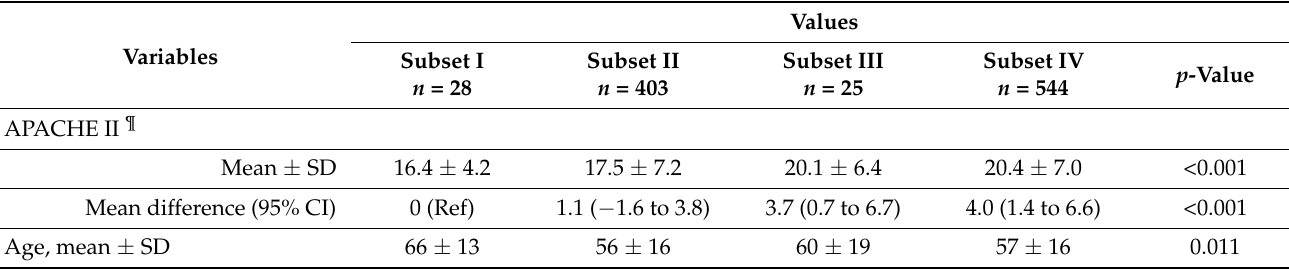
Figure 1. Distribution of 1000 patients (testing cohort) with moderate to severe acute respiratory distress syndrome (ARDS), based on cutoff values for the PaO 2 /FiO 2 ratio (150 mm Hg) and the positive end-expiratory pressure level (10 cm H 2 O) for each individual patient: ( A ) at the time of moderate/severe ARDS diagnosis (baseline); ( B ) after 24 h of standard critical care with protective mechanical ventilation. The dotted lines are placed at a PaO 2 /FiO 2 ratio of 150 mm Hg and at PEEP 10 cm H 2 O. Mortality increased as lung function deteriorated (from Subset I to Subset IV) at 24 h. Subset I: PaO 2 /FiO 2 ≥ 150 at PEEP < 10; Subset II: PaO 2 /FiO 2 ≥ 150 at PEEP ≥ 10; Subset III: PaO 2 /FiO 2 < 150 at PEEP < 10; Subset IV: PaO 2 /FiO 2 < 150 at PEEP ≥ 10.